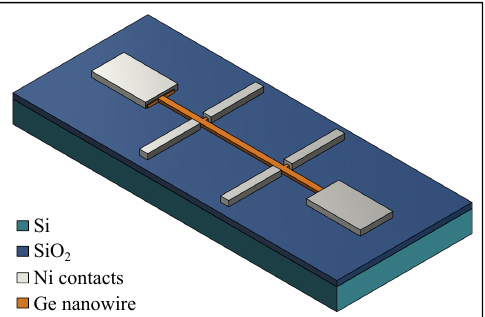
Figure 1. Schematic diagram of the fabricated device with the six-contact Hall bar